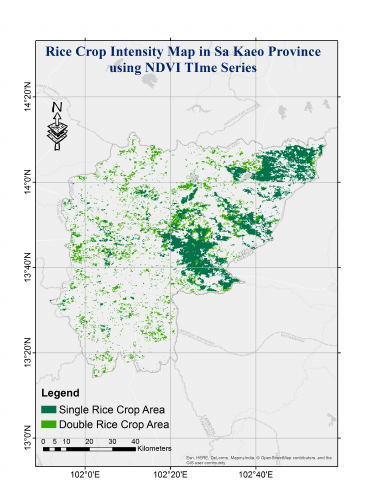
Figure 10: Single rice crop area start-of-season in Sa Kaeo Province, using NDVI